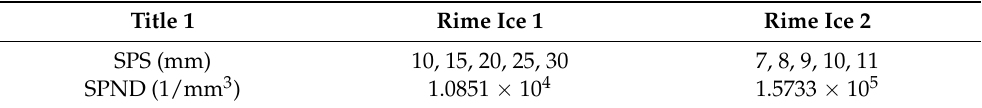
Table 4. Rime ice model parameters table.